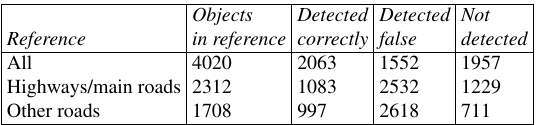
Table 4: Overview of time gaps and bands used for the investi- gated sensors